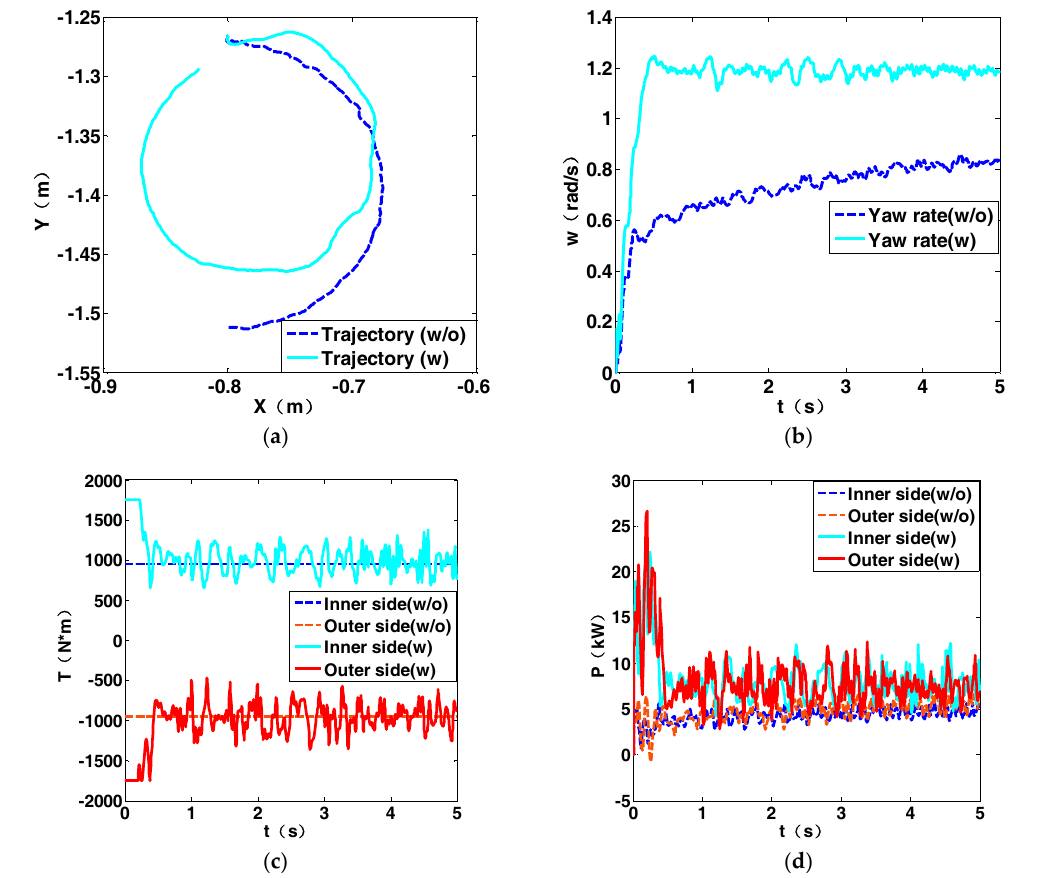
Figure 12. Simulation results of center steering: ( a ) Trajectory; ( b ) Vehicle yaw rate; ( c ) Sprocket torque; ( d ) Sprocket power.